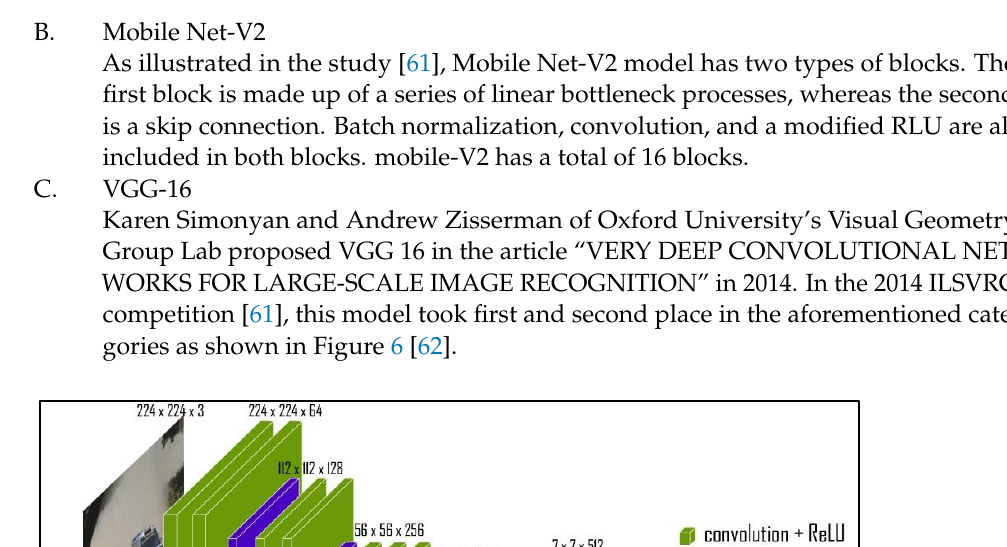
Figure 5. Presents the basic block diagram of ResNet model.